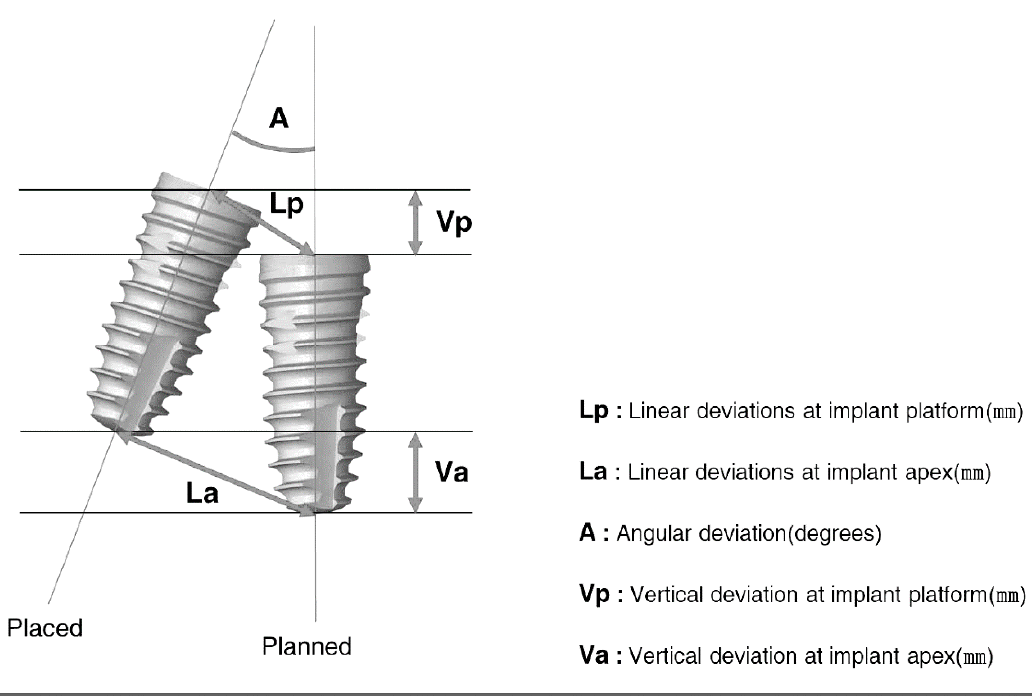
Figure 7. These parameters used to displacement measuring in general. “Lp” and “La” can each be reported by one distance, or by two individual vectors (with a horizontal and a vertical distance).